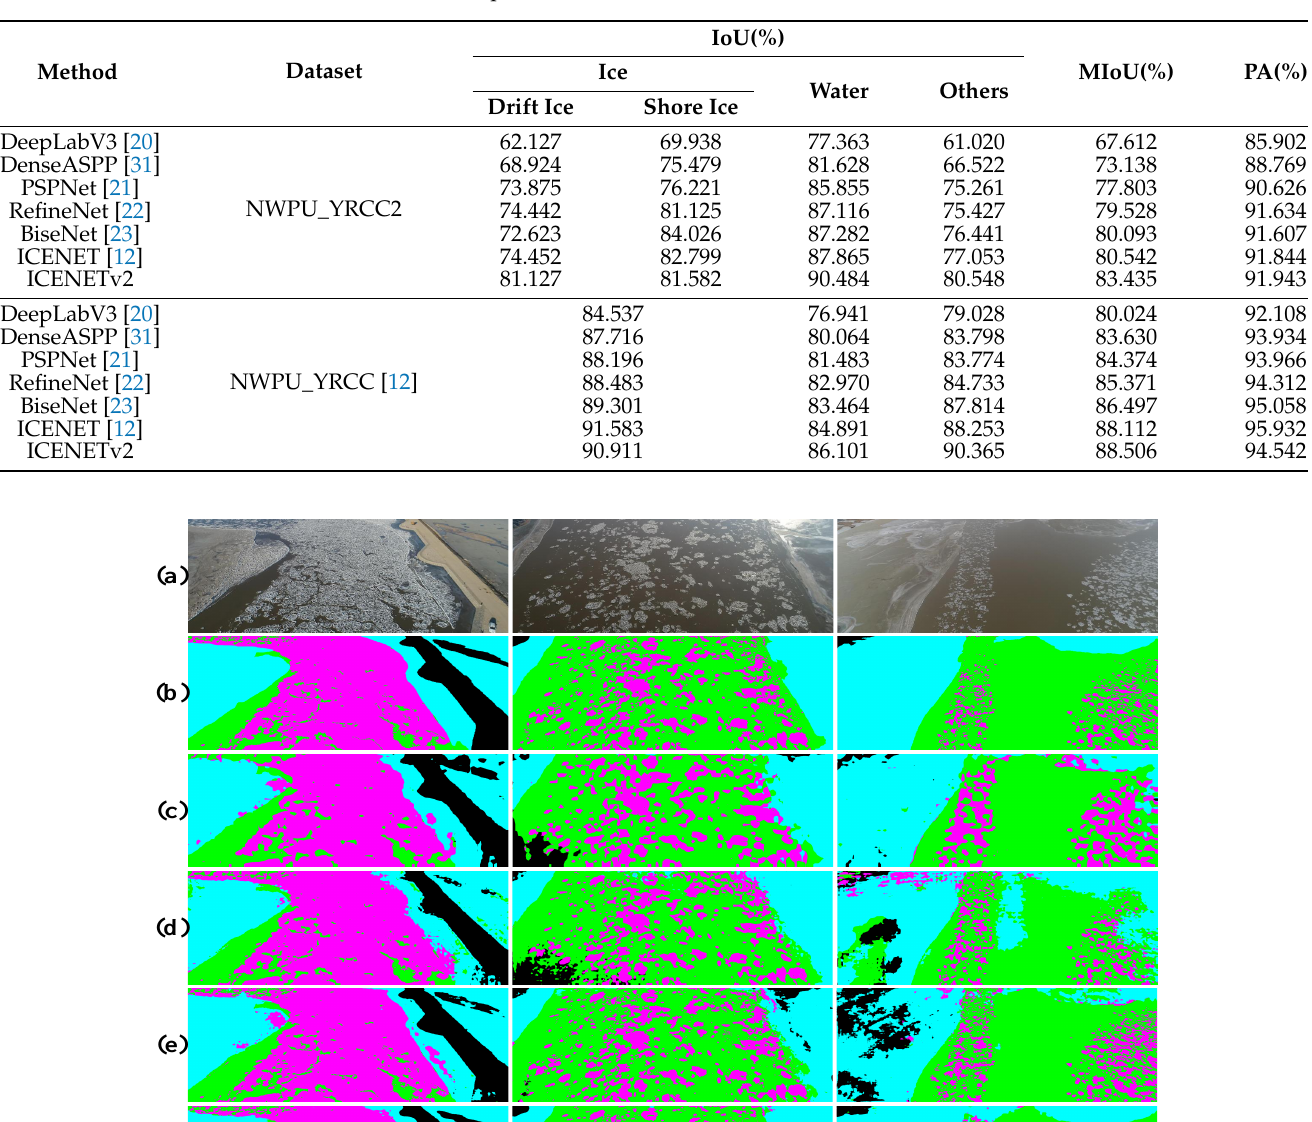
Table 5. Comparison of our ICENETv2 with other methods.